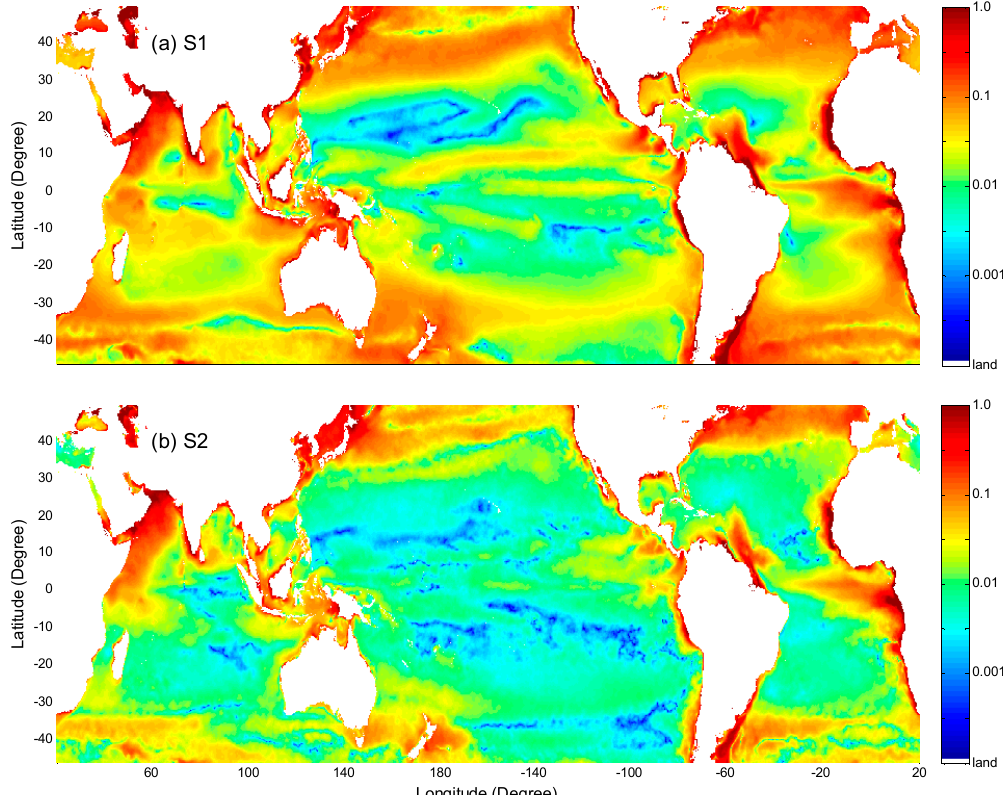
Figure 3. The amplitude images of one-cycle ( a ) and two-cycle ( b ) fitted from Equation (2) in the unit of mg/m 3 .